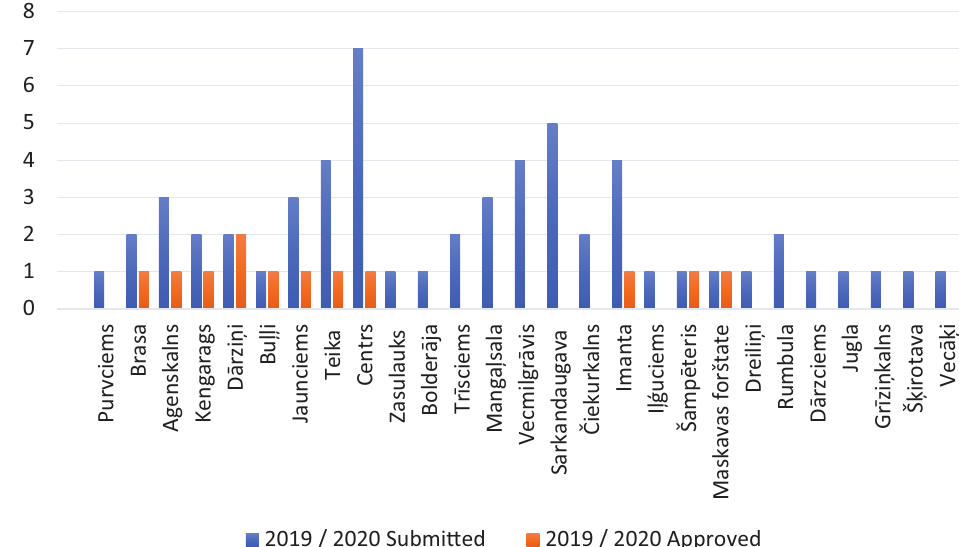
Figure 5. Submitted and approved projects in relation to neighbourhoods.